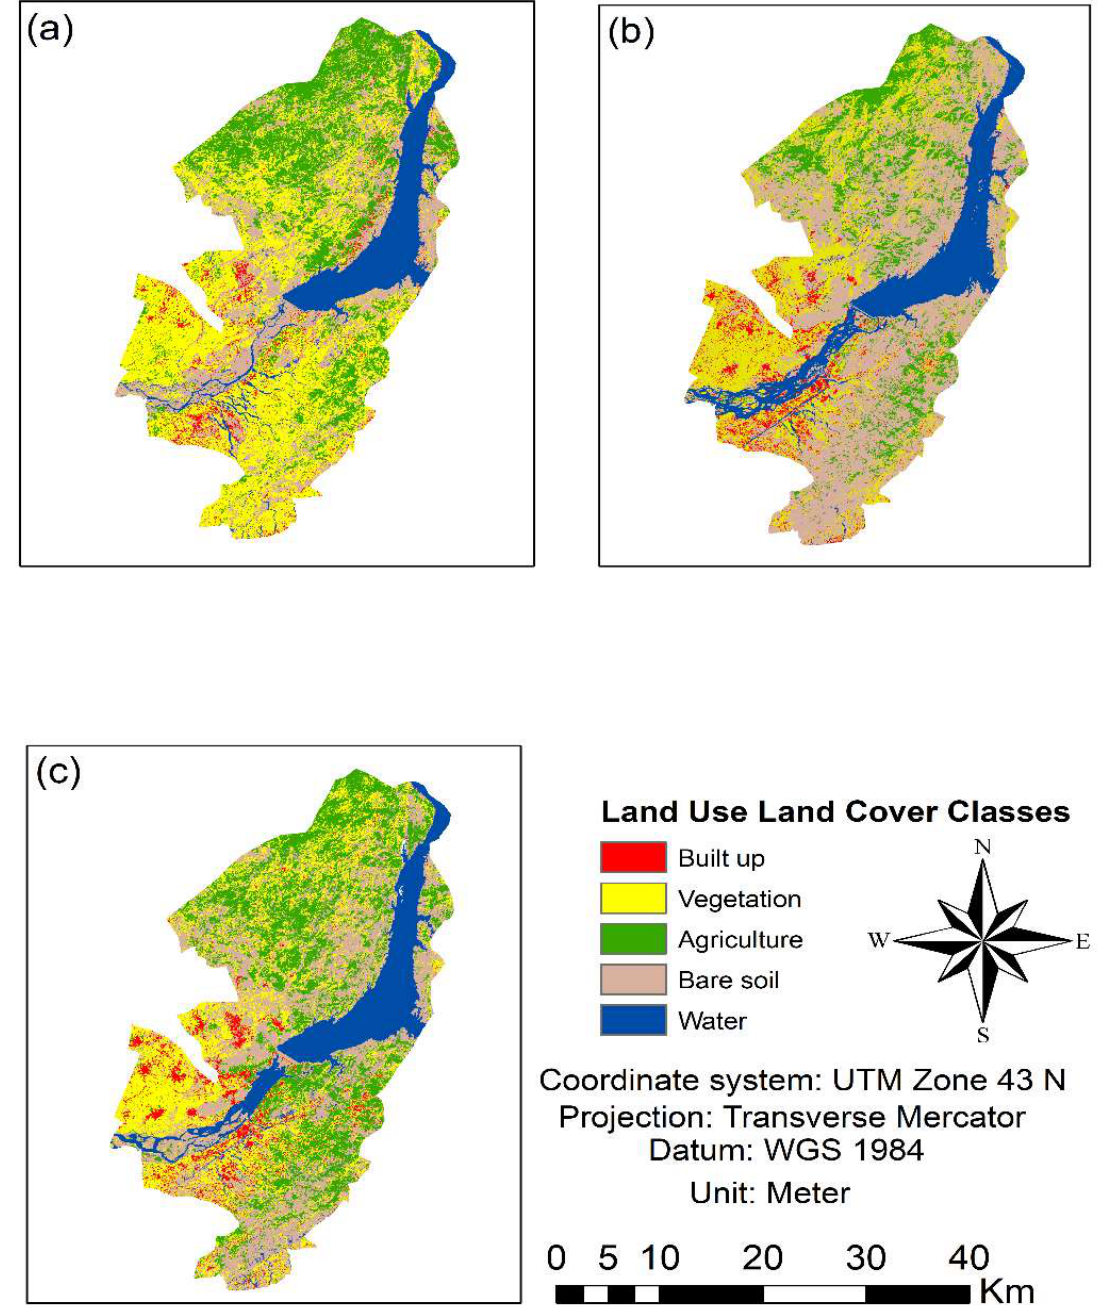
Figure 3. Past LULC maps of the years a (1987), b (2002), and c